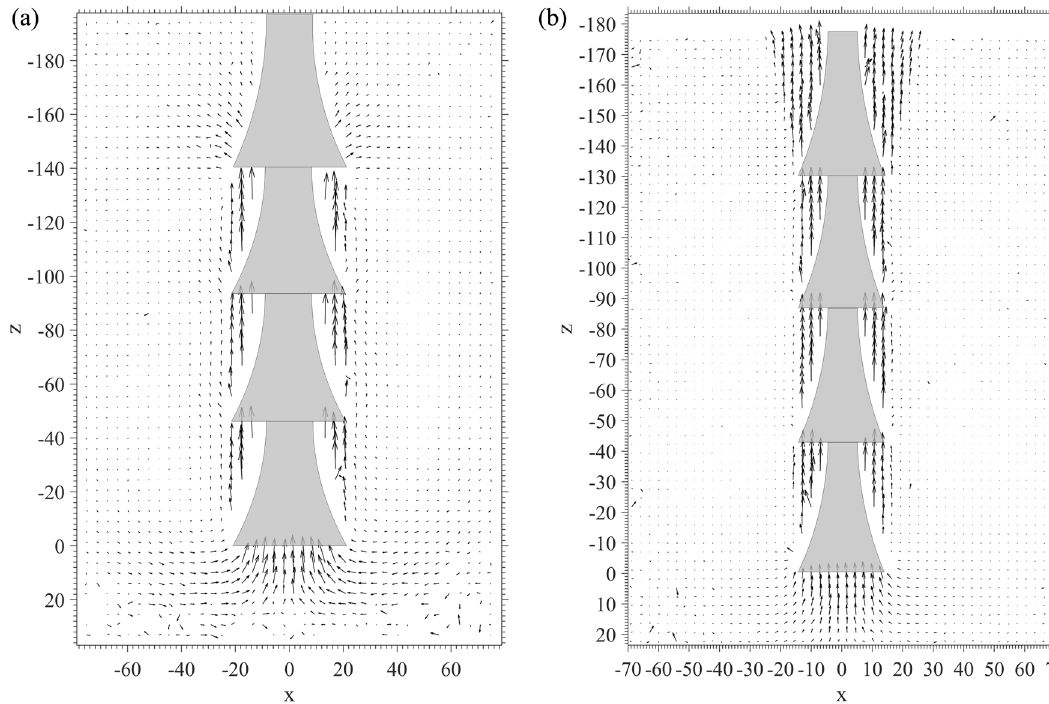
Figure 5. Displacement vectors around anchorage under pulling process. ( a ) D1. ( b ) D2.